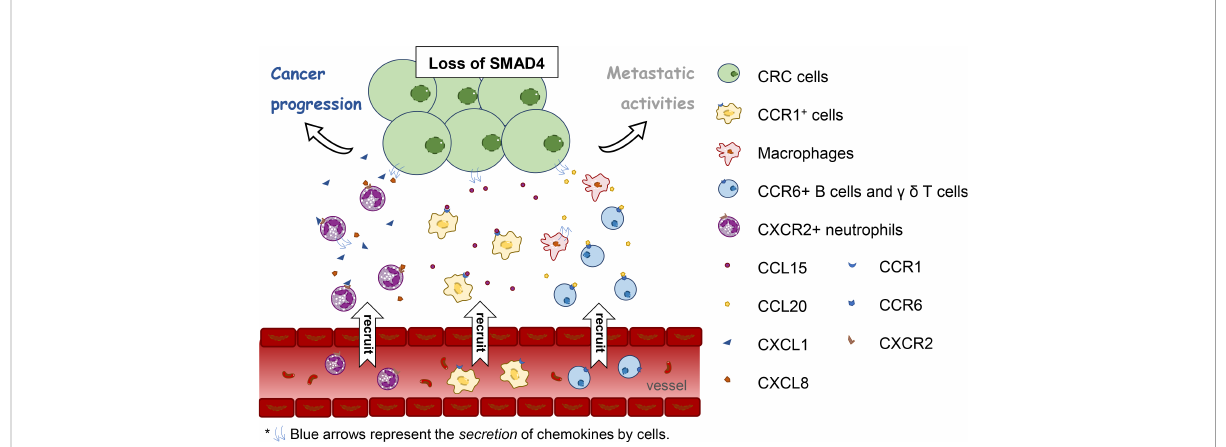
FIGURE 1 The relation between loss of Mothers Against Decapentaplegic Homolog 4 (SMAD4) in human colorectal cancer cells and tumor-in fi ltrating immune cells and its chemokines and